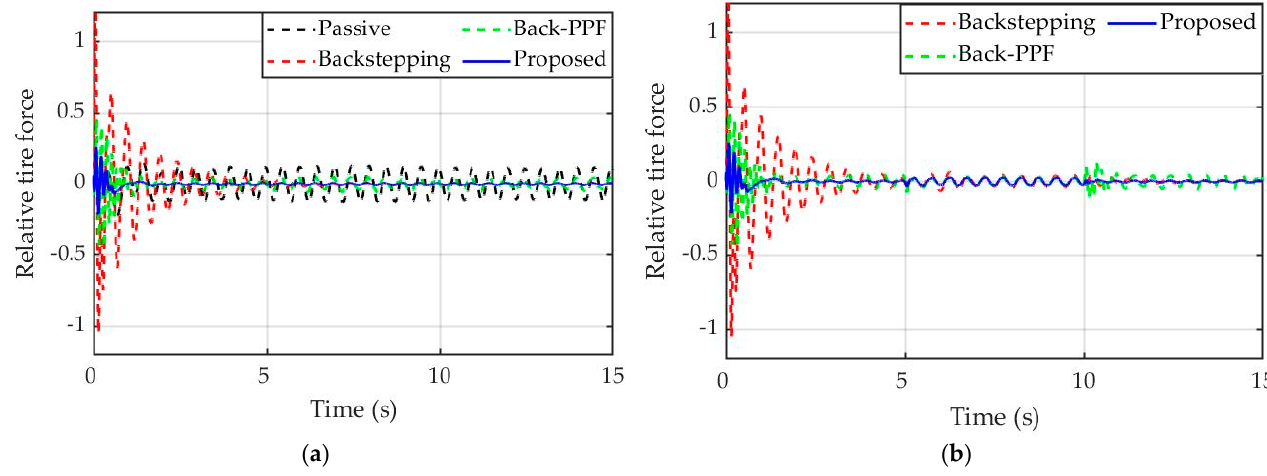
( b ) Figure 9. Control signals v F (N): ( a ) Non-fault; ( b ) Actuator-fault.